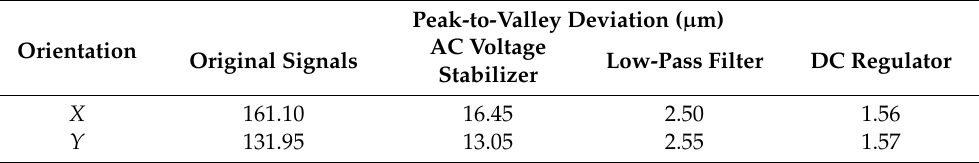
Table 2. Signal processing results for PSD output signals.